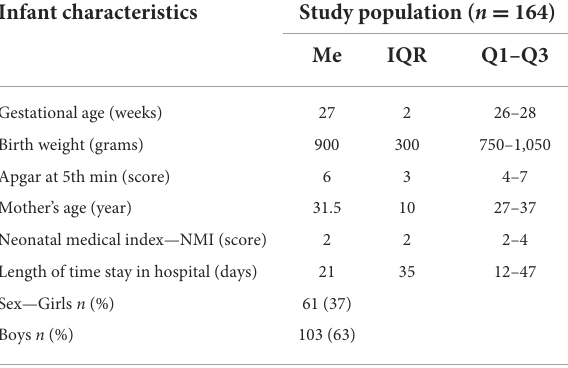
TABLE 1 Characteristics of children included in this